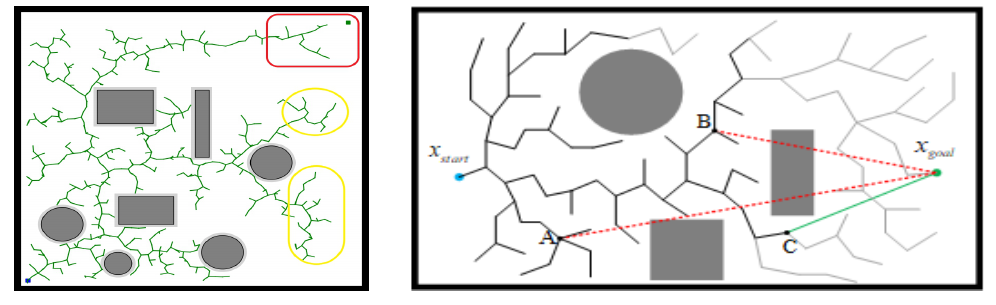
Figure 4. Illustration of the searching process without/with goal attempt. In ( a ), states in red circle are very closed to the goal point. However it takes much more time to expand randomly, like redundant expansion in yellow circles. In ( b ), dotted lines in red mean failed attempts, while the green means it succeeds in connecting to the goal